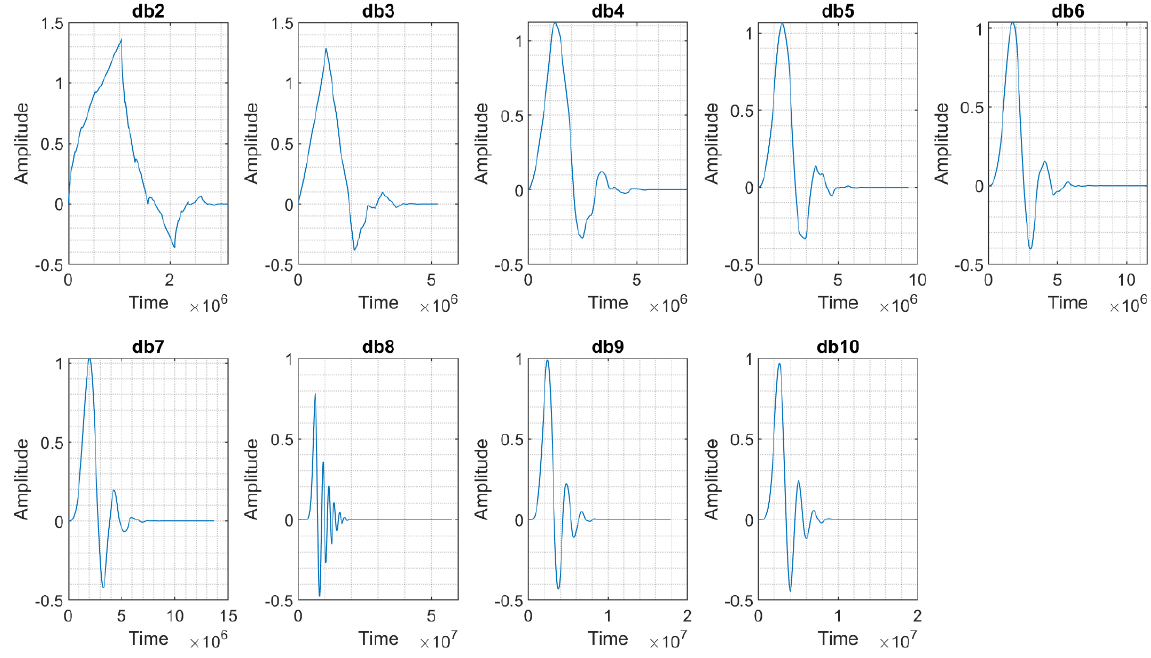
Figure 3. Wavelet Daubechies’ family.